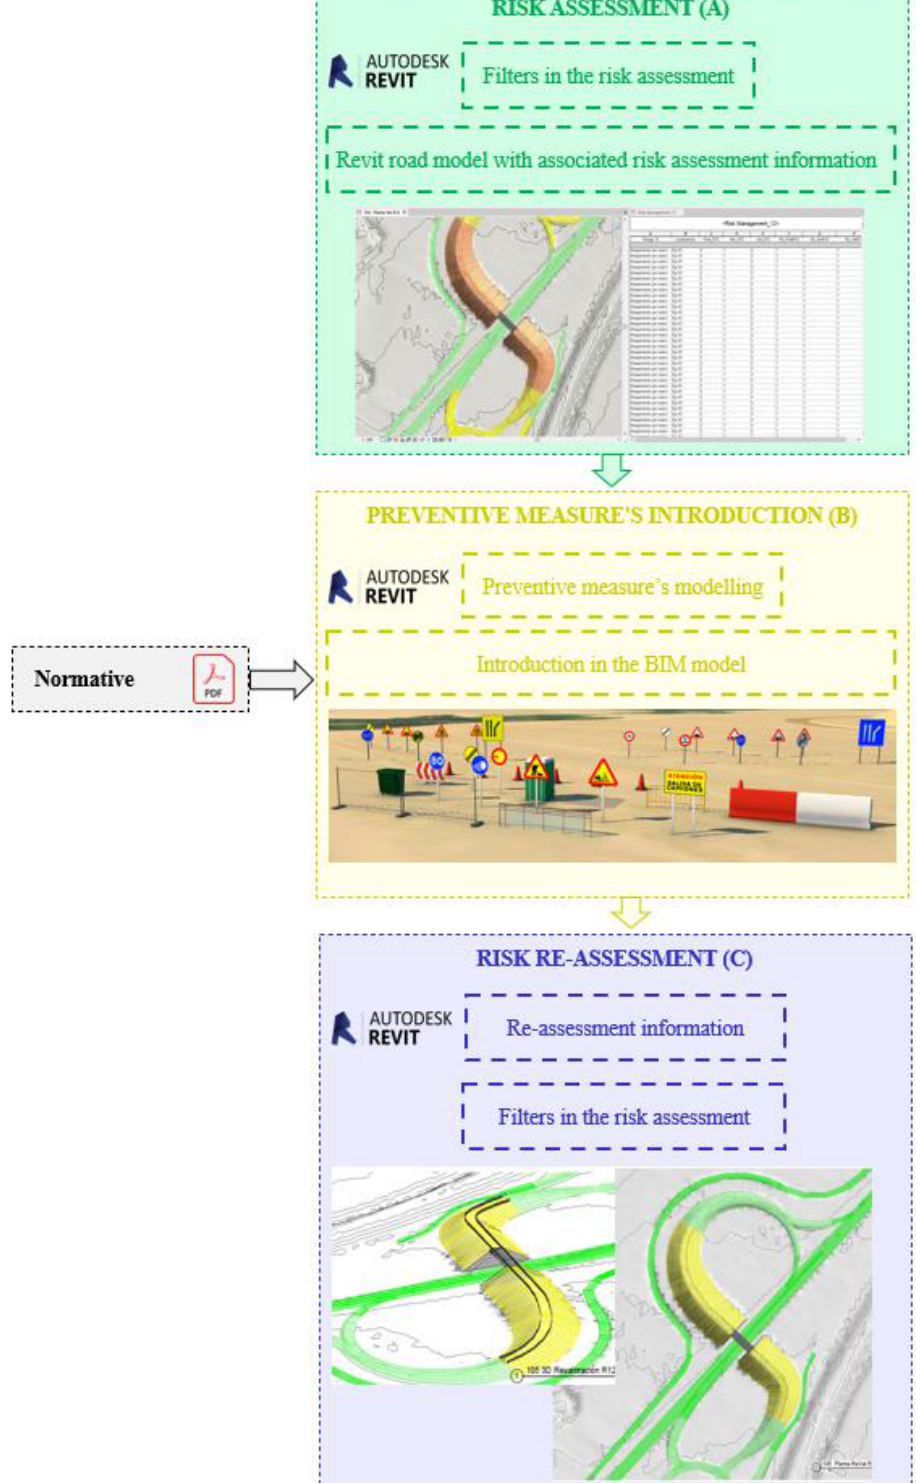
Figure 10. Introduction of preventive measures and risk reassessment.